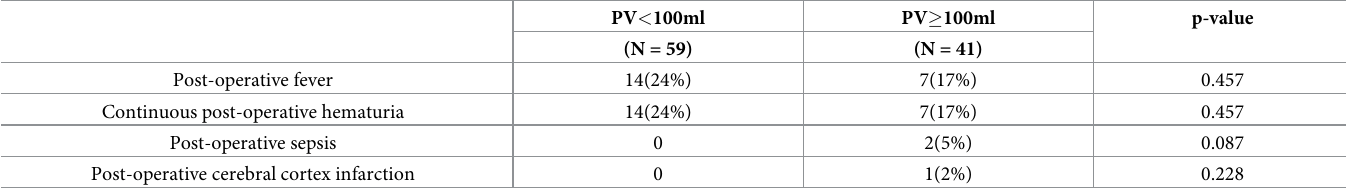
Table 4. Post-operative complications following